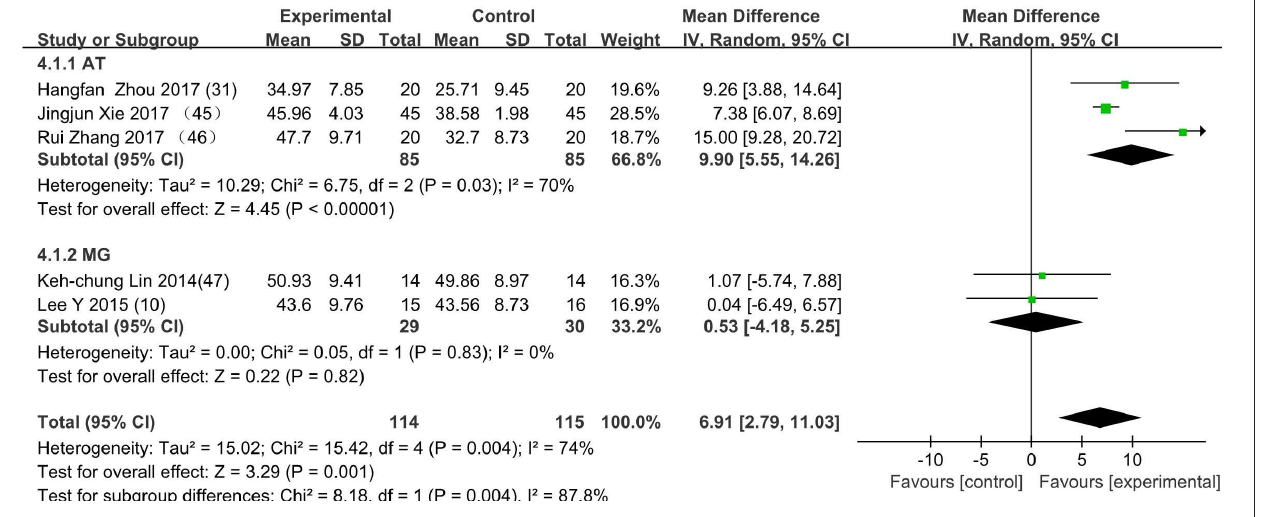
FIGURE 6 | The subgroup’s control method is adding rehabilitation therapy to MT in experimental group. AT group: (E: AT+MT/C: MT); MG group: (E: MG+MT/C: MT); E: experimental group; C: control group.